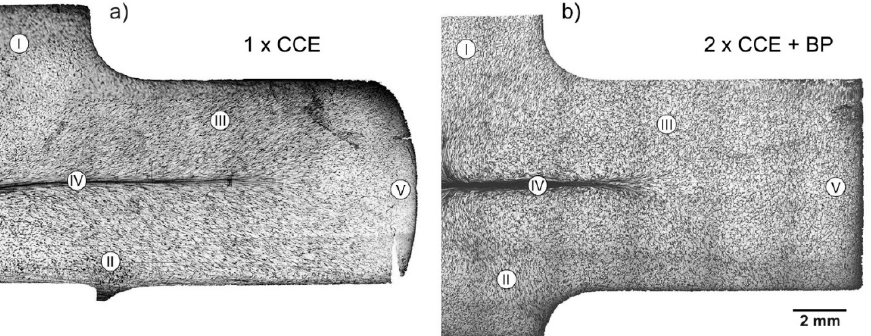
Figure 8. Cross-section of deformed alloy after: ( a ) One pass without BP and ( b ) two passes with BP = 10 kN of CCE. I–V-areas as Figure 1b.